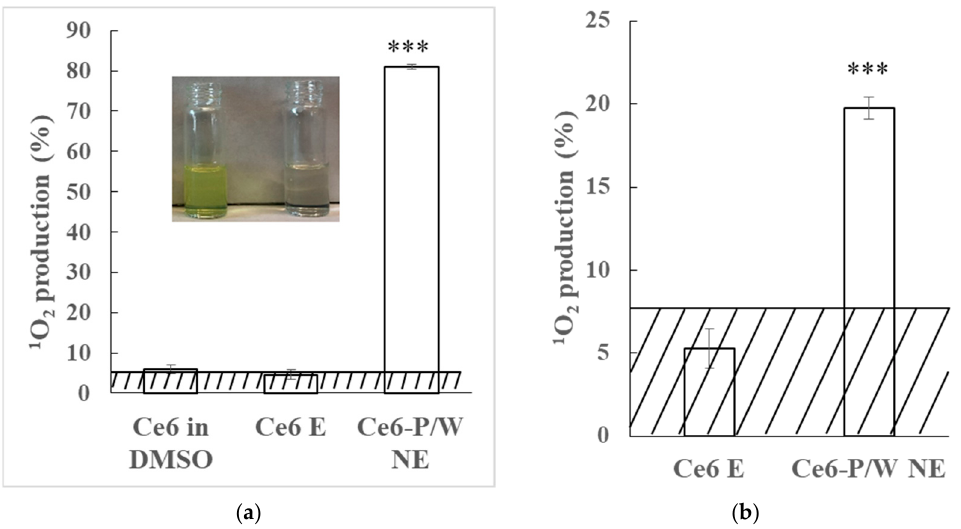
Figure 2. 1 O 2 production of the Ce6 in DMSO, Ce6 Es, and Ce6-P / W NEs under ( a ) ultrasound (0.25 W / cm 2 , 2.1 MHz, 1 min) or ( b ) light (633 nm, 50 mW / cm 2 , 2 min) irradiation in hypoxic condition at 1 mg / mL Ce6-P / W NE. The concentration was calculated as weight of Pluronic Mn 2900 and PFPE divided by the total volume. Ce6 concentration, 20 µ g / mL. The inset is a photo of the Ce6 E (left) and the Ce6-P / W NE (right) with 1,3-diphenylisobenzofuran (DPBF) after ultrasound irradiation. Data were presented as mean value ± standard deviation. After Levene’s test for equality of variances, one-way analysis of variance (ANOVA) and Bonferroni multiple comparison test was employed for the comparison of mean values. n = 3. ***, p < 0.001. The shadow represents background signals detected by control (i.e., water containing only DPBF) groups (3.3098 ± 0.9599% for ultrasonic irradiation, and 7.5879 ± 2.1061% for light irradiation). 1 O 2 , singlet oxygen. DMSO, dimethyl sulfoxide. Ce6 E, chlorin e6 emulsion. Ce6-P / W NE, chlorin e6-perfluoropolyether (PFPE) / water